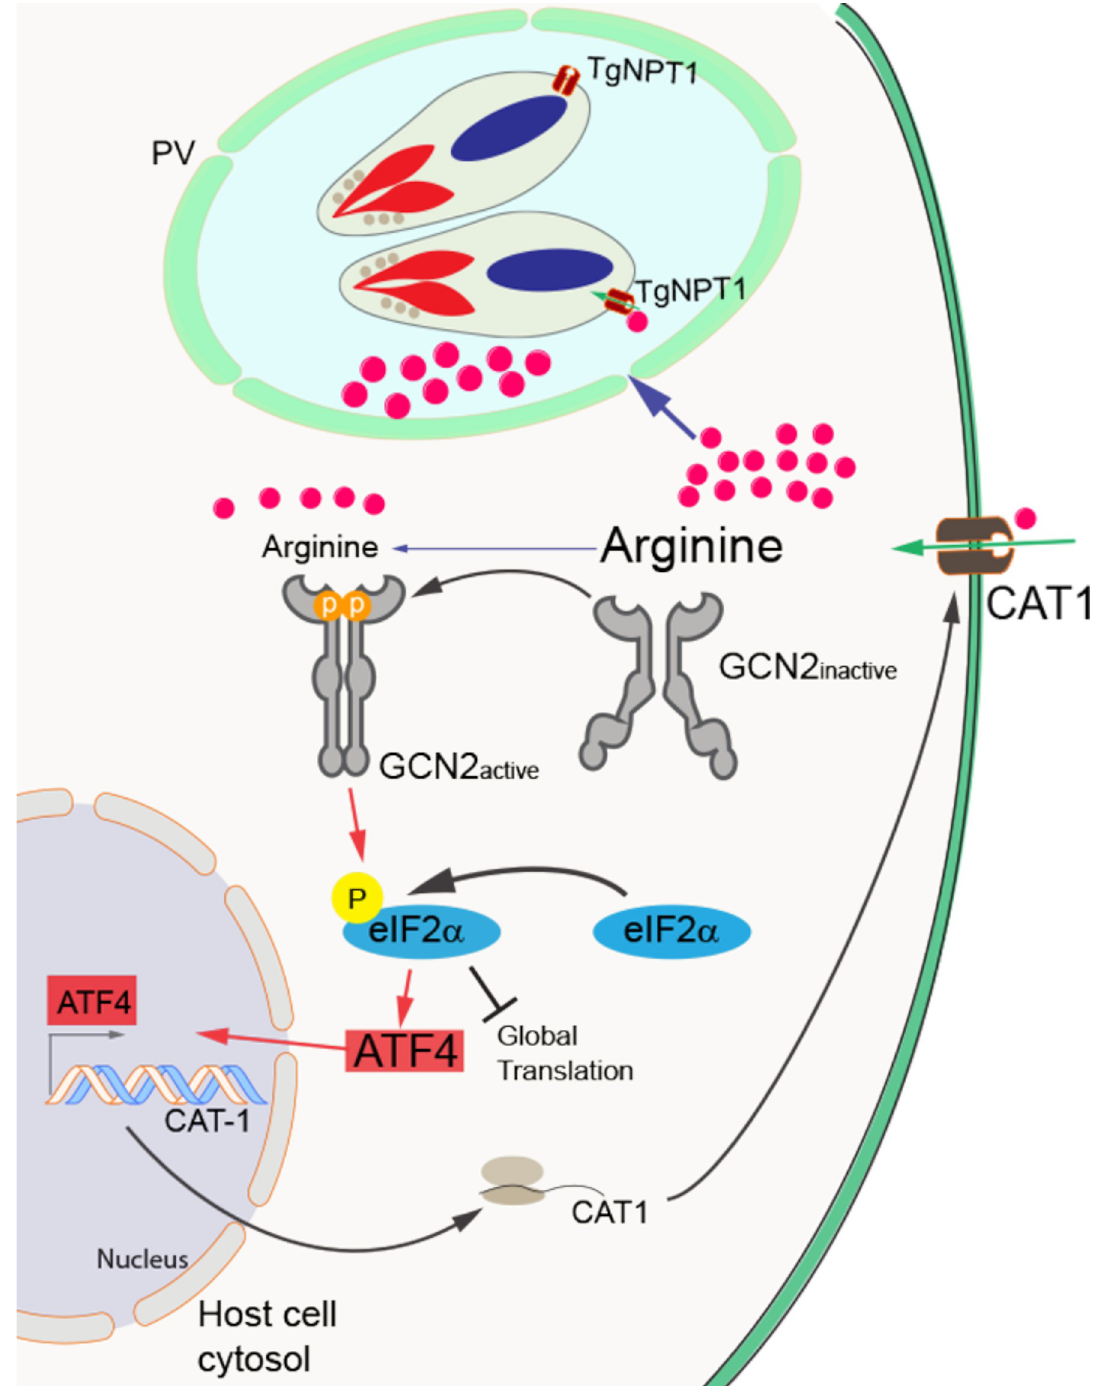
Fig 7. Host GCN2 and the downstream ISR effectors ATF4 and CAT1 help secure arginine for replication of Toxoplasma . Toxoplasma (represented as two tachyzoites residing within a parasitophorous vacuole (PV) inside a host cell) requires arginine and other nutrients from the host cell for replication. During Toxoplasma infection, the ensuing depletion of arginine in the host cell activates GCN2 to phosphorylate eIF2 α , which lowers global translation accompanied by induced preferential translation of ATF4 . ATF4 directly enhances the transcription of CAT1 , encoding a cationic amino acid transporter that facilitates arginine import into host cells, thus securing a continued supply of this essential nutrient for the intracellular parasites. Toxoplasma NPT1 facilitates arginine transport from host cells to the parasite, although it is noted that there may be other mechanisms that have yet to be elucidated for parasites to obtain arginine. Deletion of GCN2 , ATF4 , or CAT1 in the host cells inhibits Toxoplasma replication.